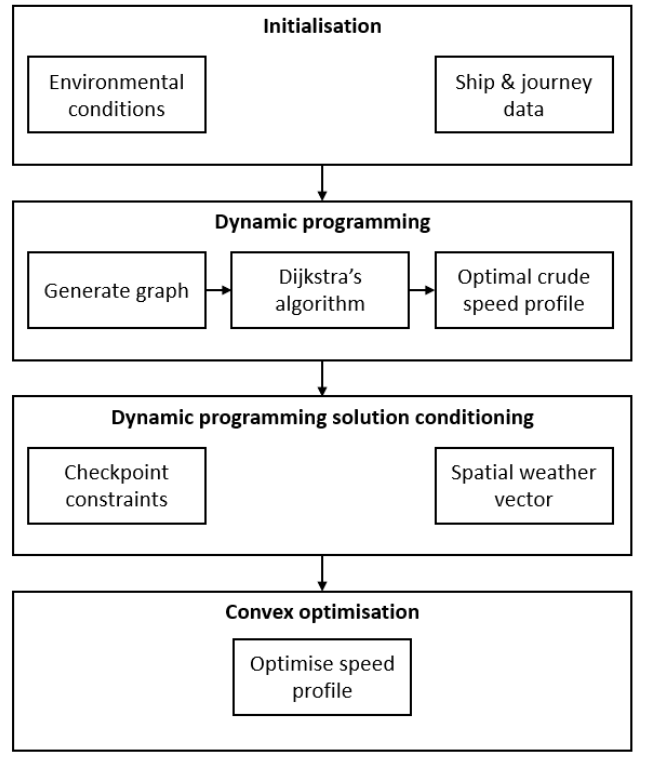
Figure 3. Scheme of the developed speed optimisation method with a combination of dynamic programming and convex optimisation.